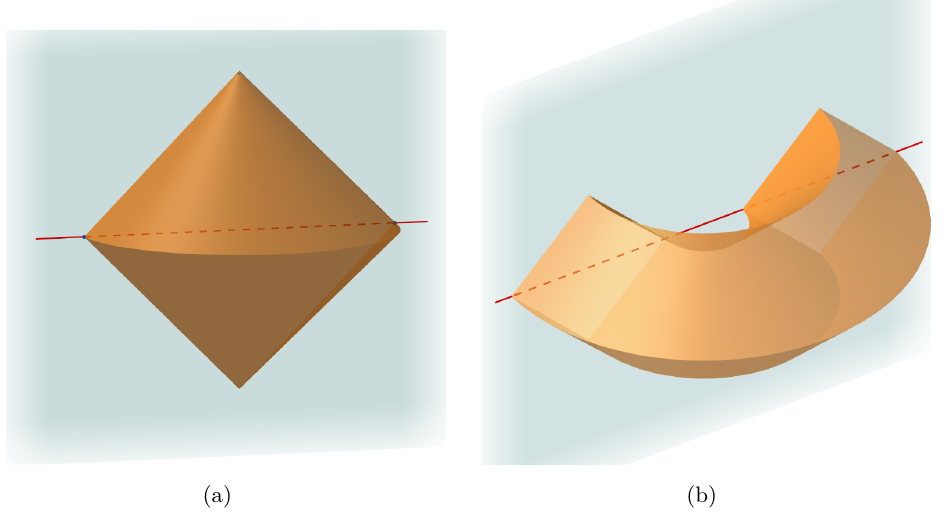
Figure 2 . Entanglement wedges related to single boundary interval and two boundary intervals (with large cross ratio) in Poincare coordinates of AdS . The blue plane denote the asymptotic 3 boundary, the red line is the Cauchy surface on the boundary. The closed region bounded by yellow lightsheets and blue boundary is the entanglement wedge, whose intersection with the boundary is the domain of dependence of boundary